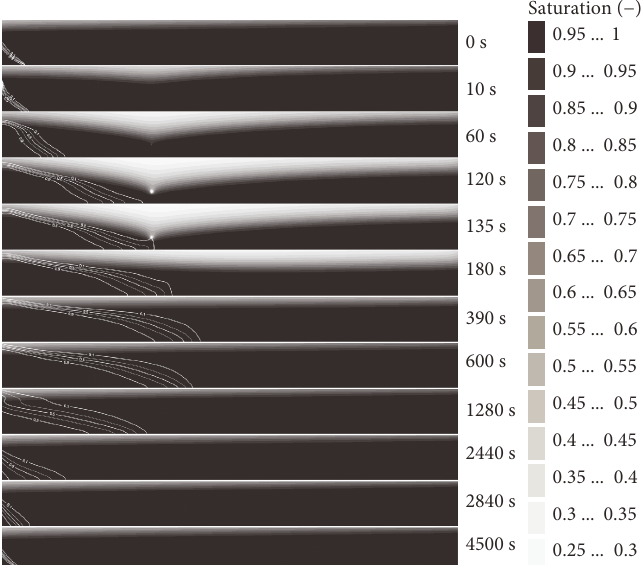
= 0s to t = 4500s with relative concentration contours of 0.1, 0.3, 0.5, 0 end